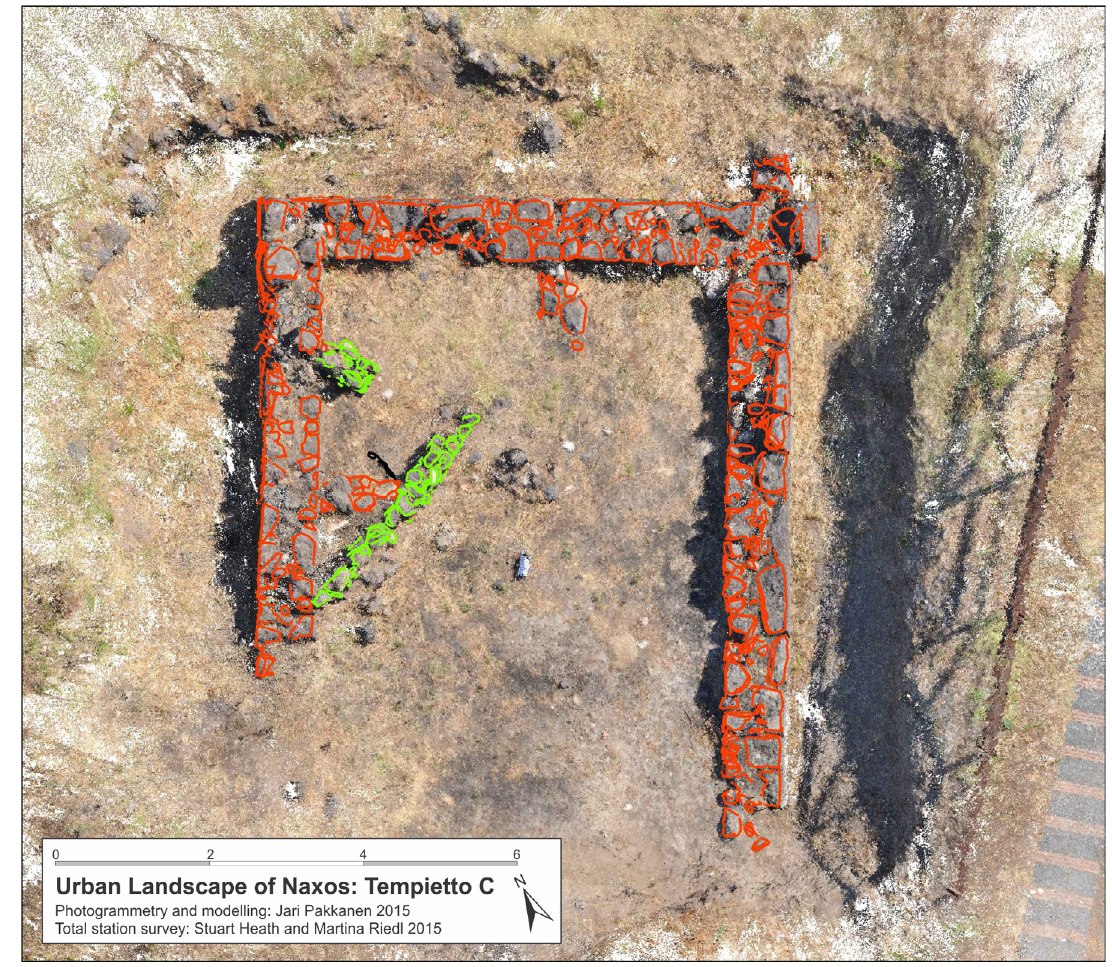
Figure 4. Eastern half of Tempietto C. Dense point cloud produced by photogrammetry exported to CAD; 3D reflectorless total station line drawing recorded as separate layers. Orange = Early Archaic; light green = Classical (Jari Pakkanen, Stuart Heath, & Martina